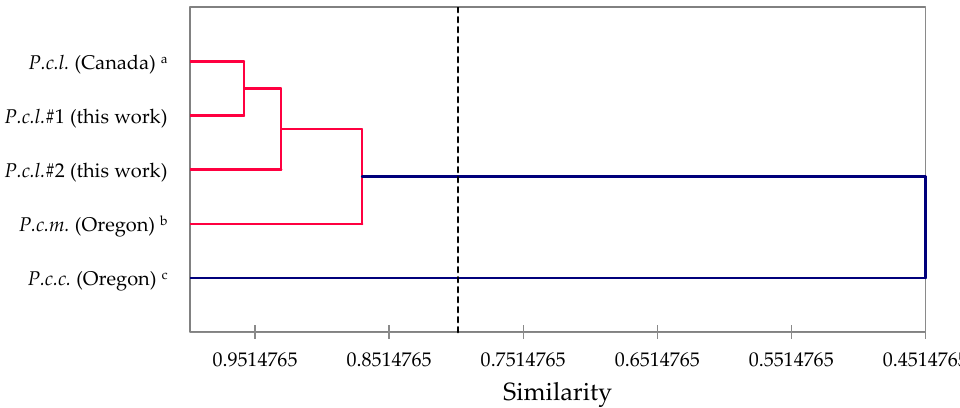
Figure 12. Dendrogram based on hierarchical cluster analysis of Pinus contorta leaf essential oil compositions. P.c.l. = Pinus contorta subsp. latifolia , P.c.m. = Pinus contorta subsp. murrayana , P.c.c. = Pinus contorta subsp. contorta . a Pauly and von Rudloff, 1971 [33]. b Ankney et al., 2021 [10]. c Ankney et al., 2022 [11].